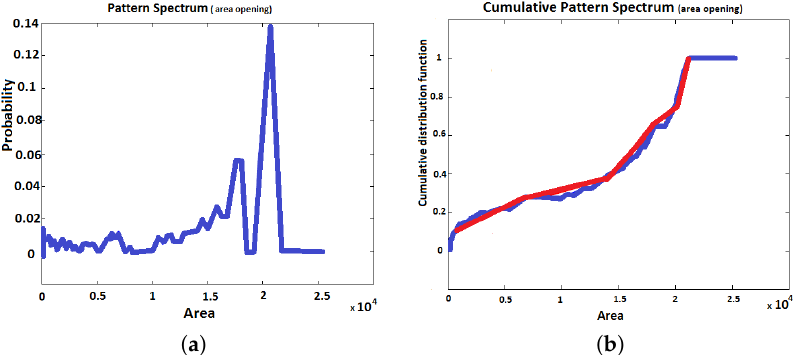
Figure 3. The pattern spectrum (PS) by area openings of a grey-scale image using 100 scales in ( a ); In ( b ), in blue, its corresponding cumulative pattern spectrum (CPS); in red, its approximation with S = 8